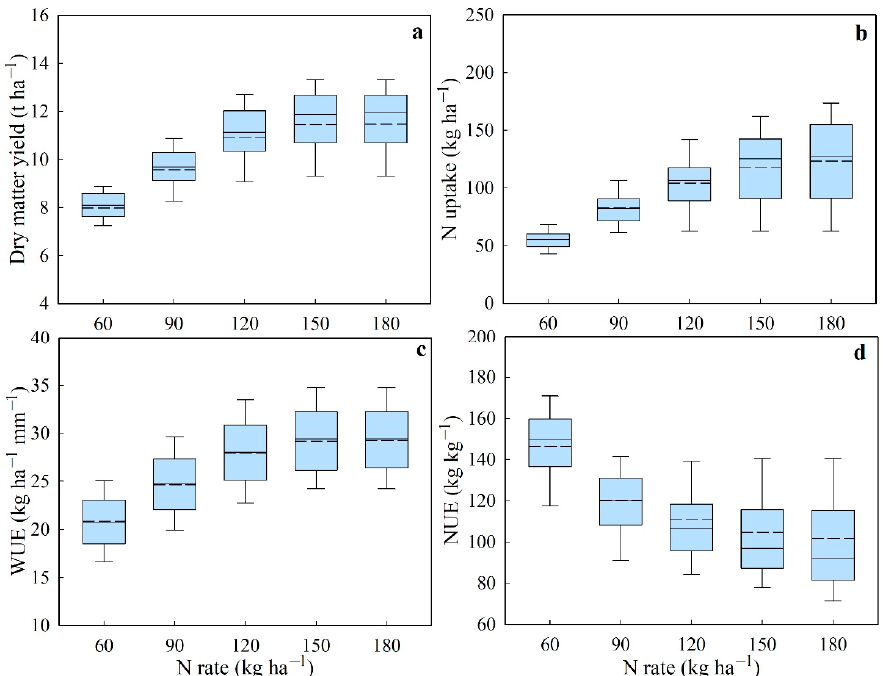
Figure 7. The 30-year average dry matter yield ( a ), N uptake ( b ), WUE ( c ), and NUE ( d ) of oat as affected by the amount of irrigation on the Tibetan Plateau. The bottom and top edges of the box show the 25th and 75th quantiles, the solid line is the data median, and the dotted line is the data average.